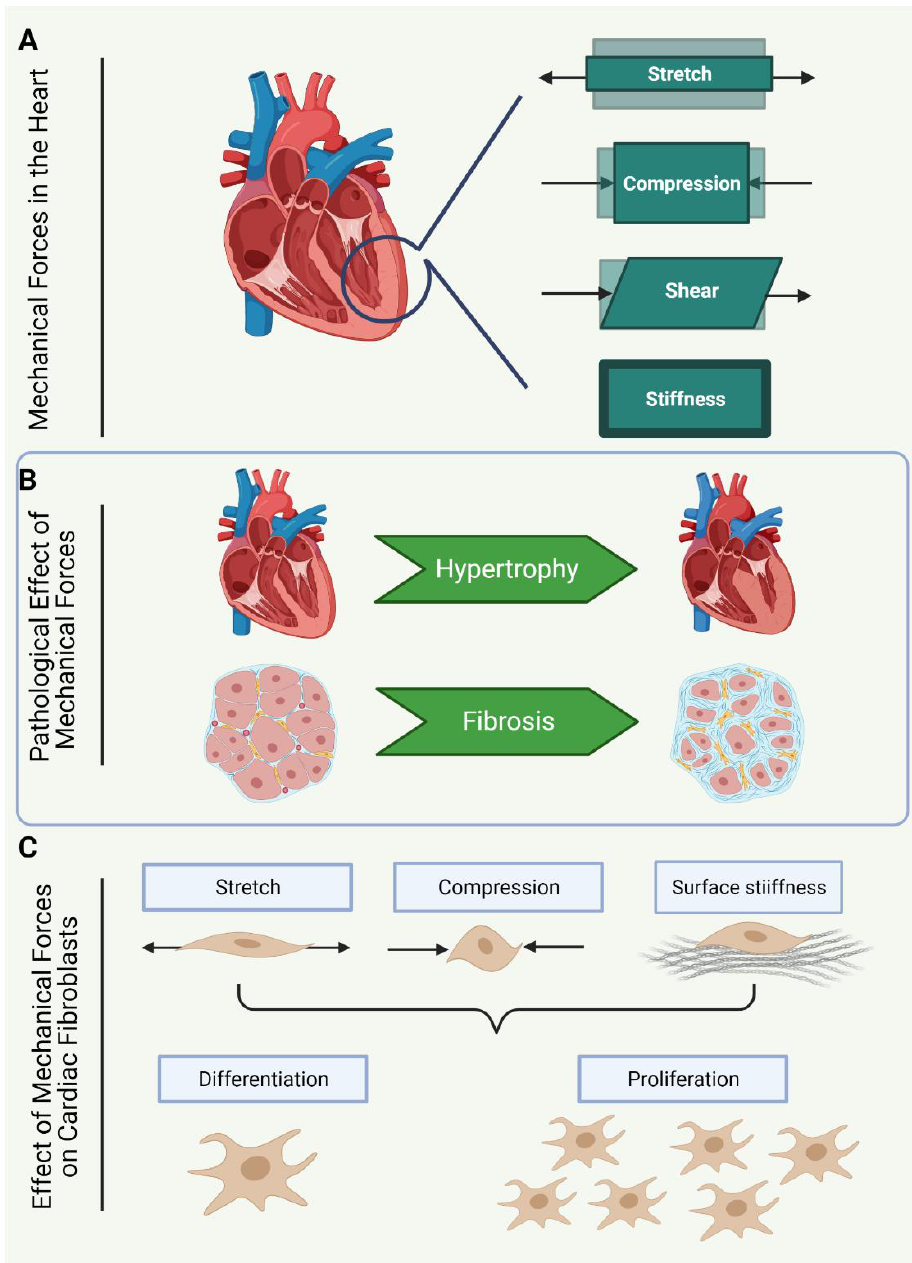
Figure 1. The pathophysiological effect of mechanical forces on the heart. ( A ) The heart is subject to mechanical forces such as stretch and compression as a consequence of the rhythmic beating of the heart, shear stress due to blood flow, and tension due to the stiffening of tissues under certain physiological and pathophysiological conditions. ( B ) Mechanical forces which occur during pathophysiological conditions prompt cardiac fibrosis and cardiomyocyte hypertrophy, resulting in stiffening and thickening of the muscular walls of the heart. ( C ) Cardiac fibroblasts are thought to be sensitive to the changes in mechanical forces of the heart. In culture, cardiac fibroblasts are sensitive to the stiffness of the culture surface and tensile forces, such as stretch and compression. In response to tensile forces and surface stiffness, cardiac fibroblasts transdifferentiate into myofibroblasts and proliferate more